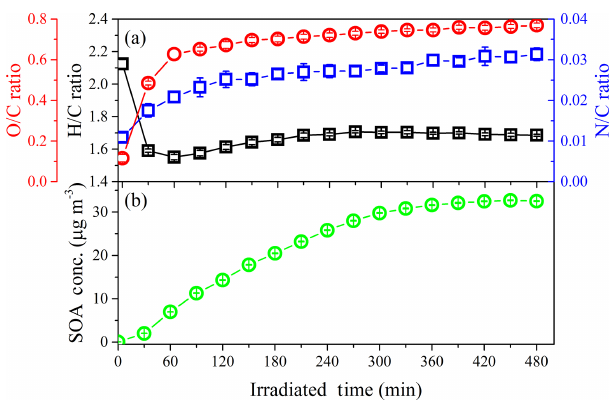
Figure 8. Time evolution of (a) O / C, H / C, N / C, and (b) SOA con- centration in the photo-oxidation of gasoline vapor in the presence of 150ppb NH 3 (Exp.